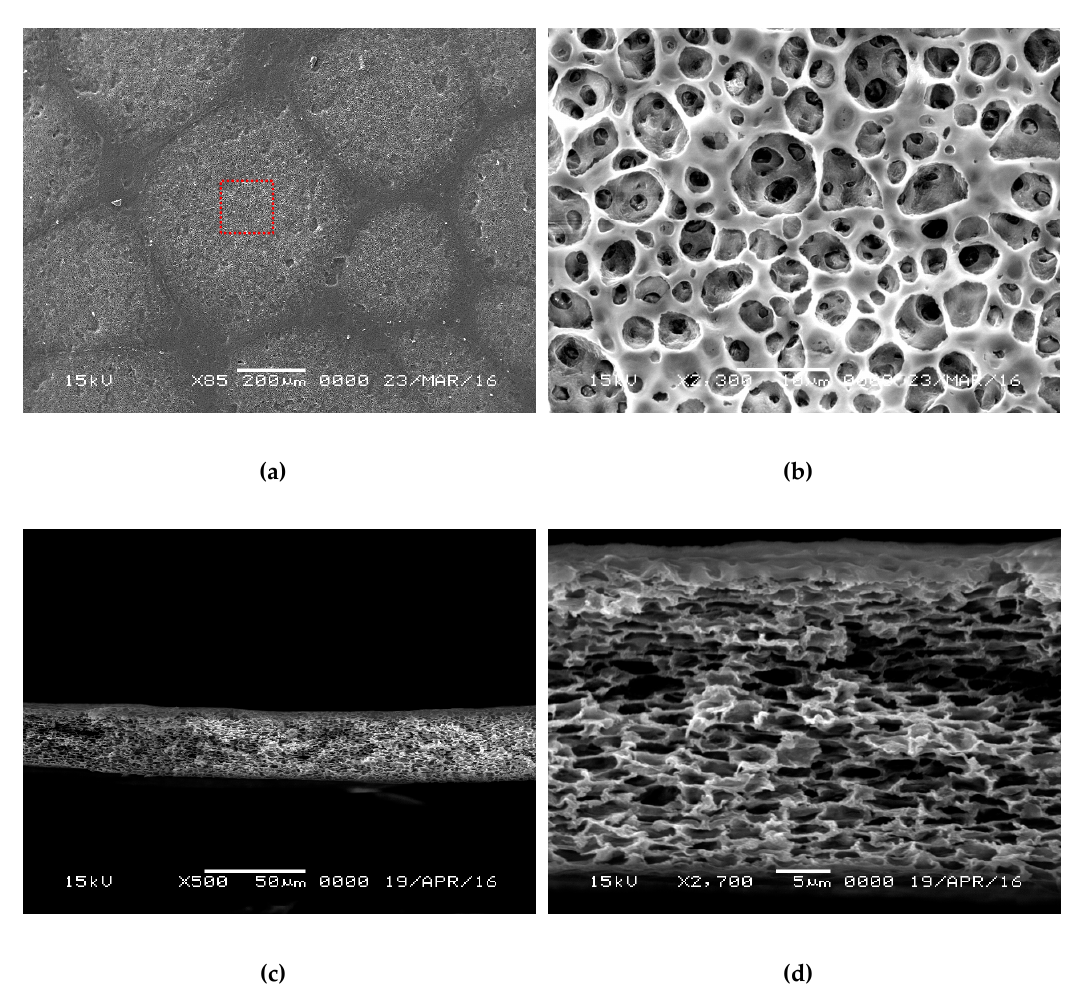
Figure 1. SEM images: ( a ) plane view of porous CA polymer exposed to external water-pressures (scale bar = 200 µm), ( b ) the enlarged red-dot square in plane view (scale bar = 10 µm), ( c ) cross-section view (scale bar = 50 µm) and ( d ) enlarged view of cross-section (scale bar = 5 µm). The water flux through the porous CA polymer containing different ratios of Cd(NO 3 ) 2 ·4H 2 O is